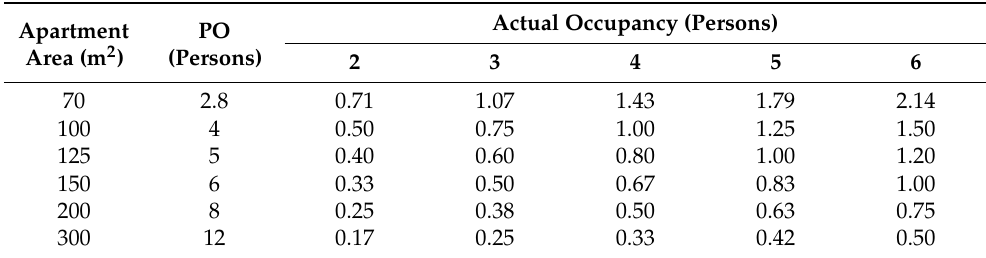
Table 2. Occupancy Correction Factor (OCF) for various apartment areas and occupancy